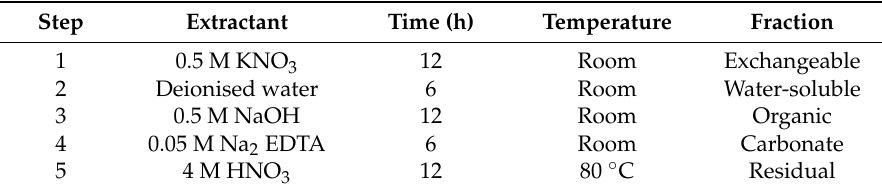
Table 4. Steps showing the extractant, reaction time, temperature, and fraction extracted at each step in the sequential extraction